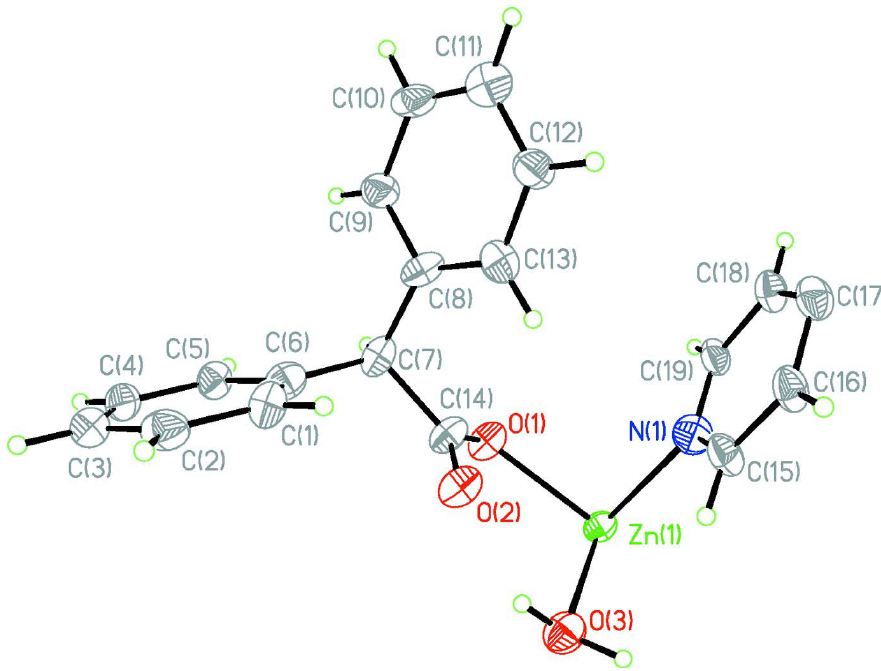
Figure 1 The asymmetric unit of (I), showing displacement ellipsoids at the 30% probability level.